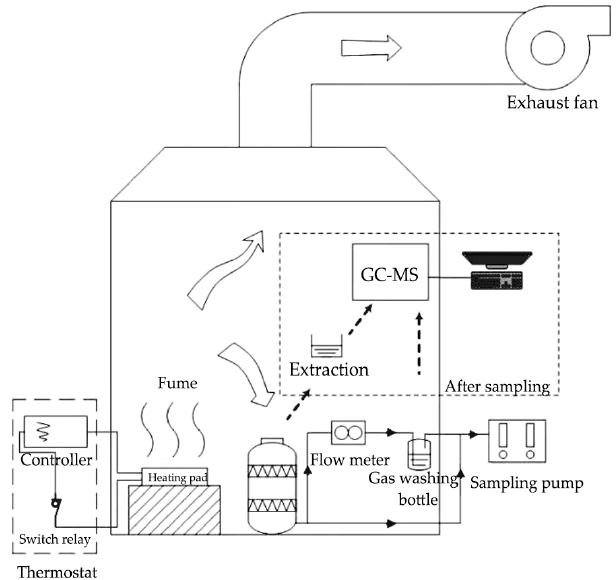
Figure 1. Schematic illustration of the experimental apparatus.